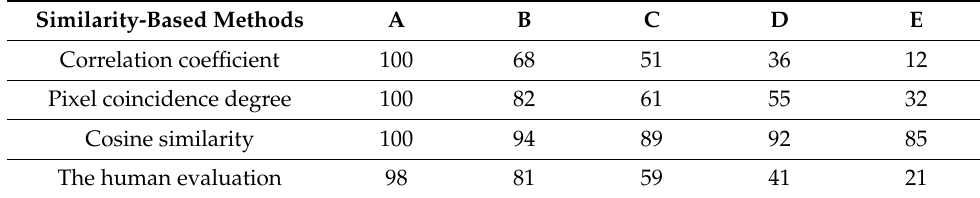
Table 5. Comparison of evaluation